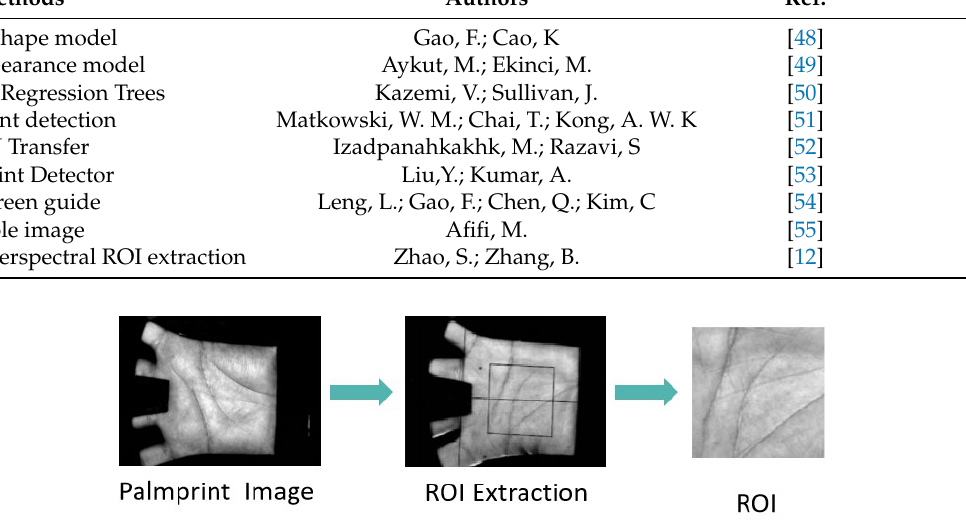
Figure 5. The brief pipleline of ROI extraction from the palmprint